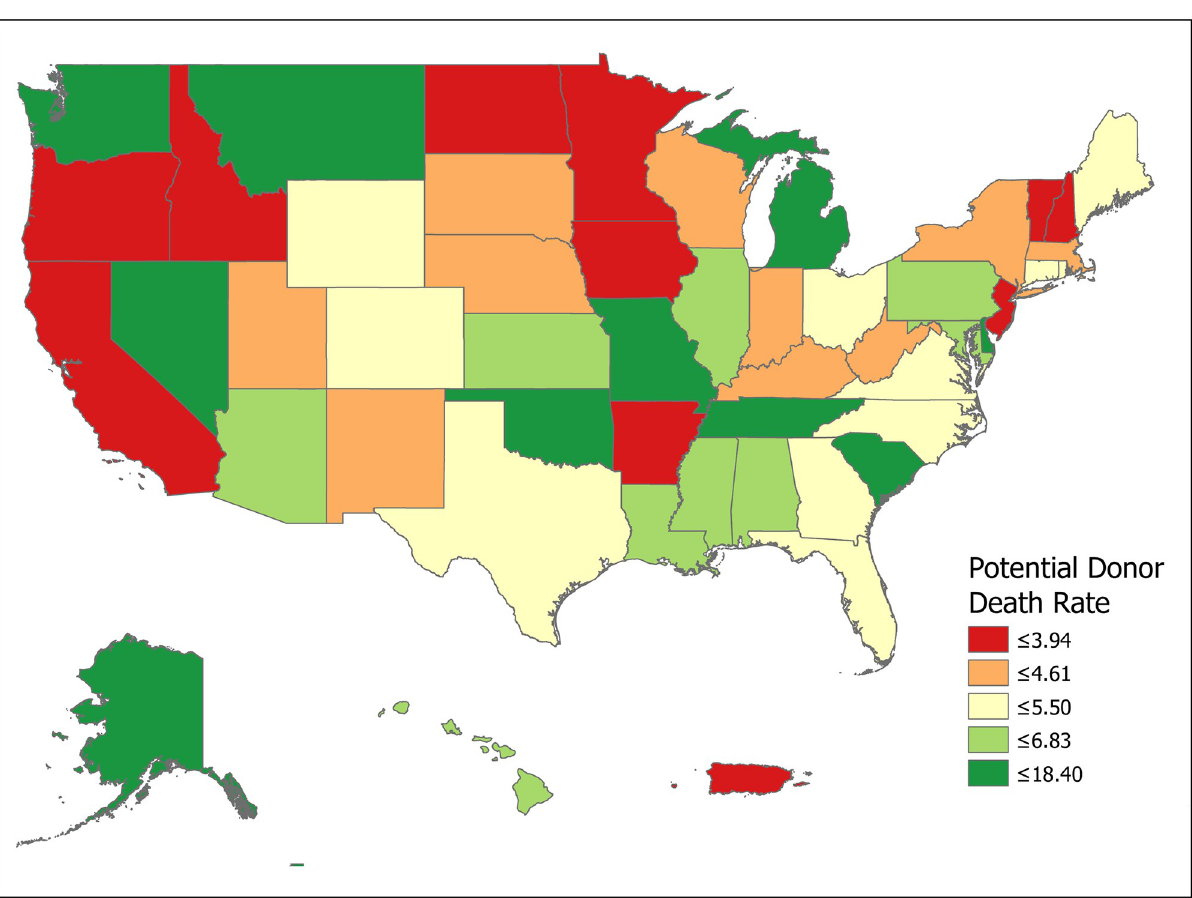
Fig 4. 2018 potential donor death rates, non-registered ( q 1 ). Data come from Tables 1 and 2. Maps created by ArcGIS Pro, URL: https://www.esri. com/en-us/arcgis/products/arcgis-pro/overview. Base Map: World Light Gray Base, URL: https://services.arcgisonline.com/arcgis/rest/services/Canvas.